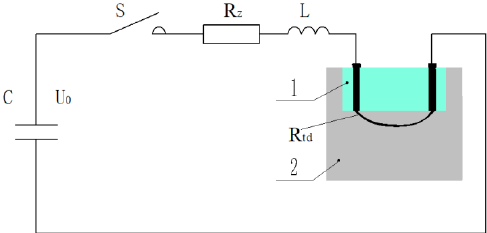
Figure 3. Equivalent circuit of high-voltage electro pulse breakdown: 1 — water medium, 2 — rock, C — storage capacitor, S — high-voltage pulse switch, R z — circuit resistance, L — inductive inductance, R td — resistance of plasma channel.